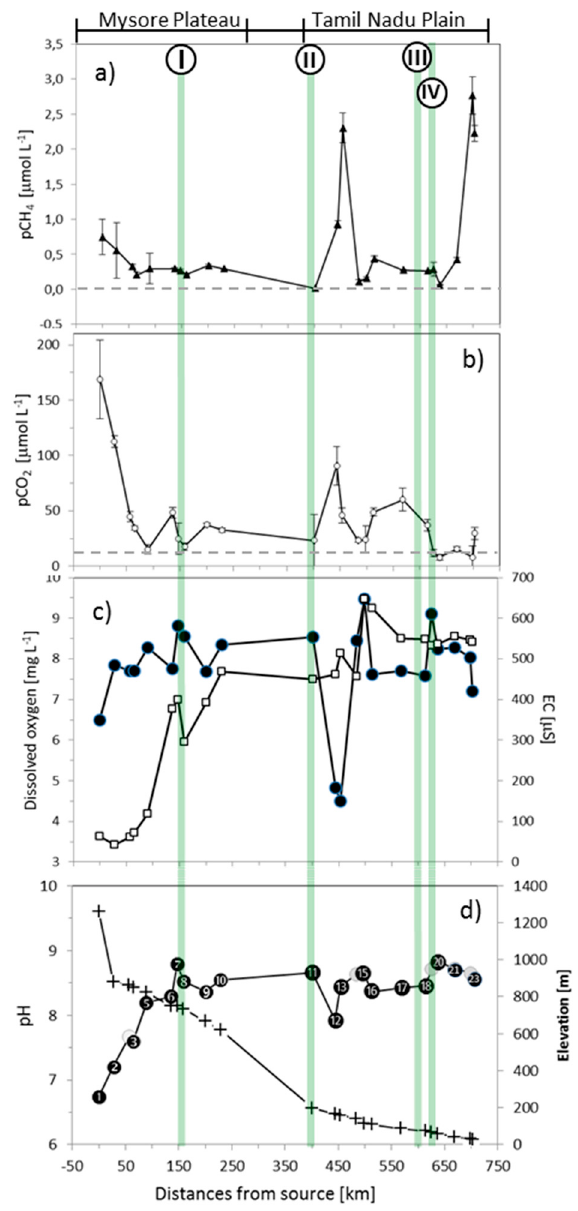
Figure 3. Spatial distribution of ( a ) pCH 4 (triangle); ( b ) pCO 2 (white circle); ( c ) dissolved oxygen (DO, black circle) and electrical conductivity (EC, open squares); and ( d ) pH and elevation along the Cauvery River from the source to the river mouth. White numbers in black circles indicate station numbers in the pH line, line with crosses indicates elevation above the mean sea level along the entire river. The river stretch is divided into two large plateaus on the basis of topography, Mysore Plateau and Tamil Nadu Plain; the latter extends after Mettur Dam. The four vertical green lines characterize four large dams built in the Cauvery River: I: Krishnarajasagara, II: Mettur, III: Mukkombu, and IV: Grand Anaicut. The dashed horizontal line represents the mean value for the atmospheric equilibrium of CO 2 (12.1 µ mol L − 1 ) and of CH 4 (0.0026 µ mol L − 1 ). Standard deviations are given for pCO 2 and pCH 4 .